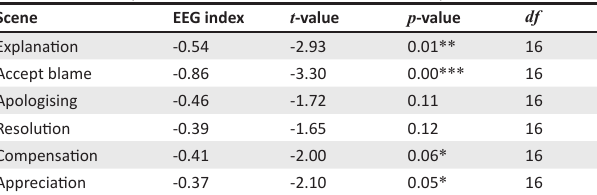
TABLE 5: Female respondents: Less attractive male service provider.